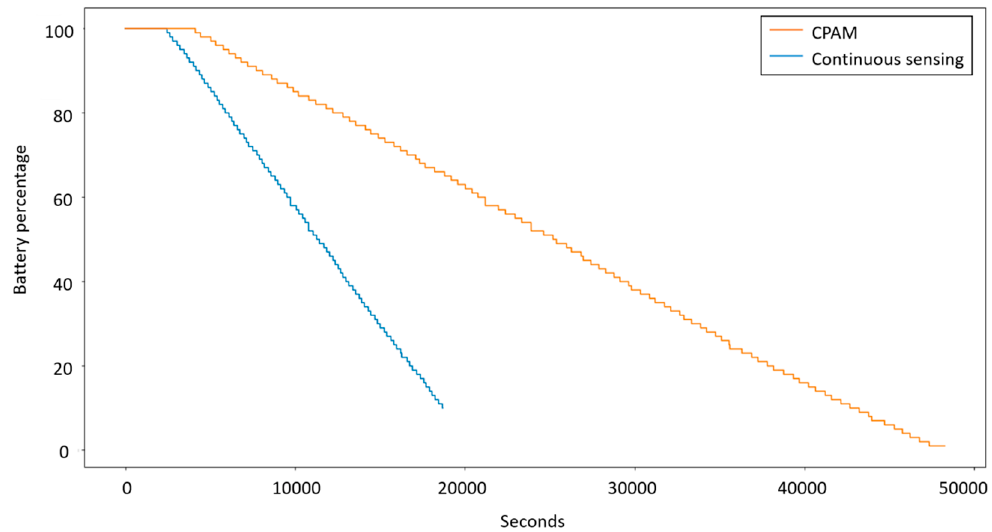
Figure 14. Average battery consumption using continuous and CPAM-based sampling of movement and location.